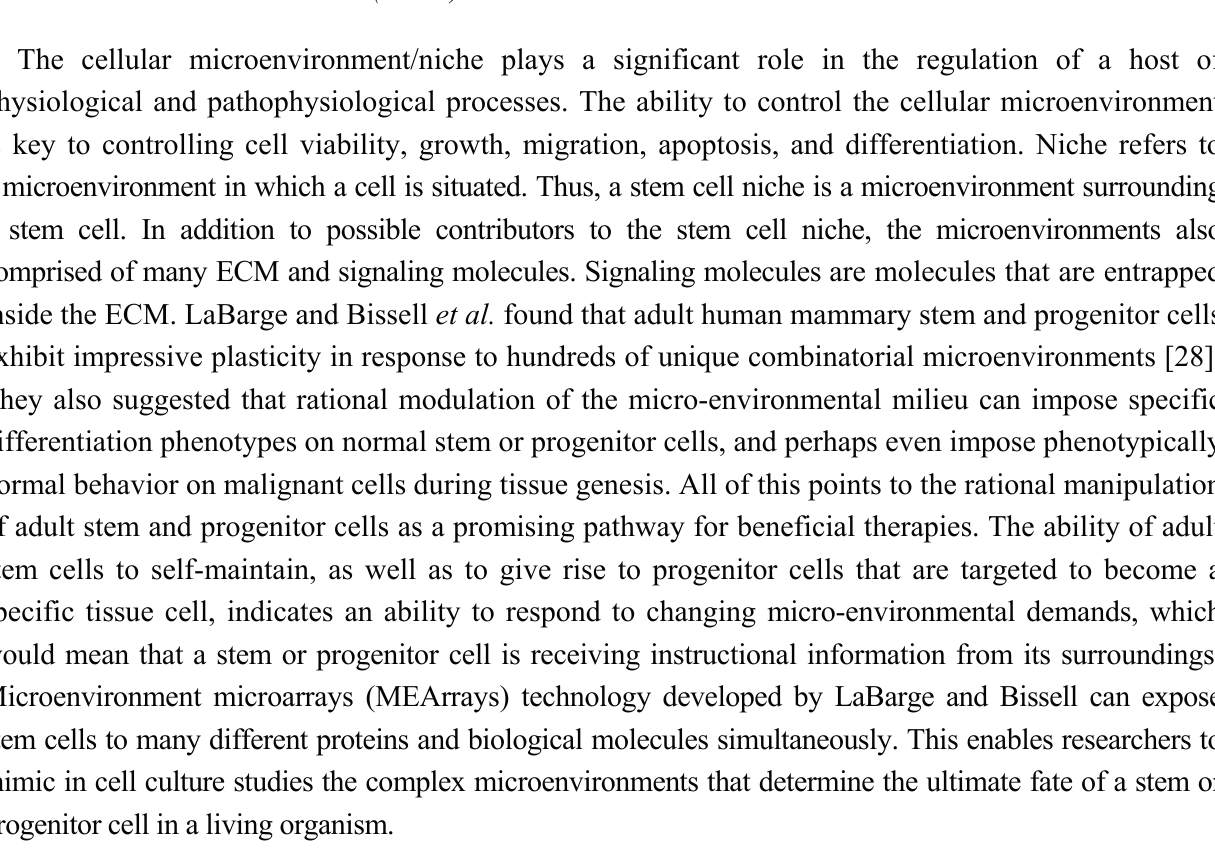
Figure 2. Cellular microenvironment showing main and specific components of extracellular matrix